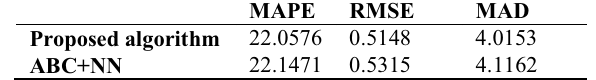
Table 10, Comparative analysis of proposed rainfall prediction